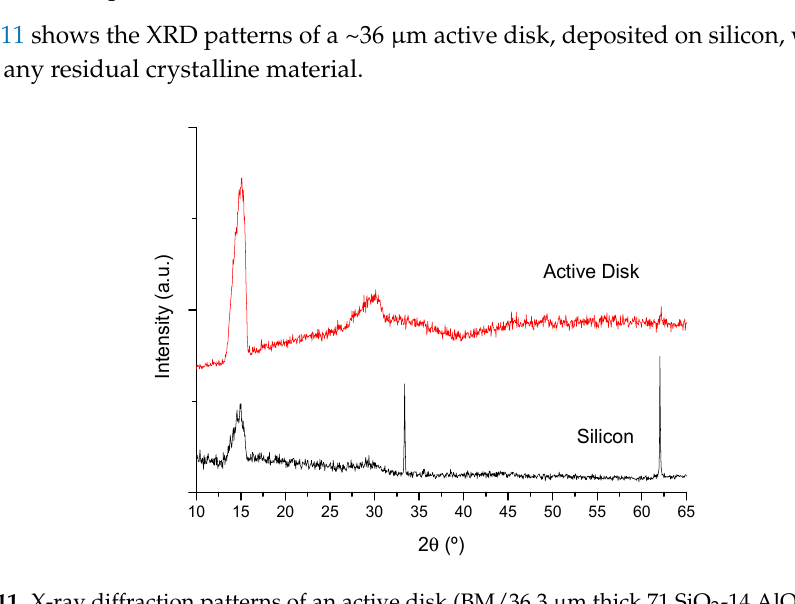
Figure 11. X-ray diffraction patterns of an active disk (BM/36.3 µ m thick 71 SiO 2 -14 AlO 1.5 -15 YbO 1.5 film/ARC) on a silicon substrate.